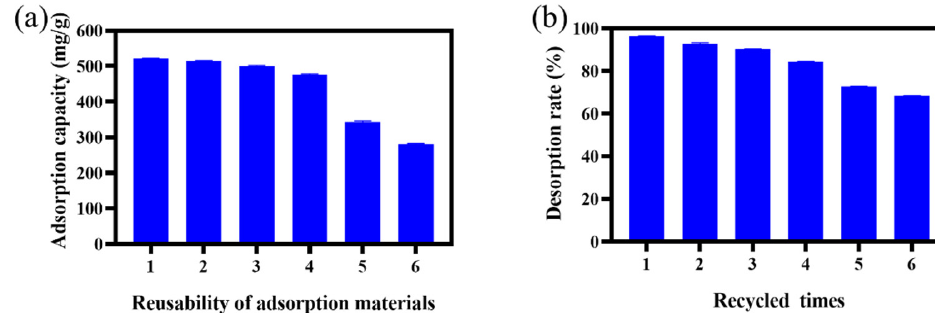
Figure 12. ( a ) The reusability of PILs and ( b ) the recycle time of